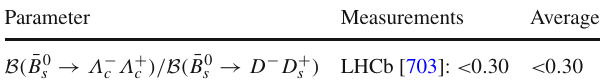
Table 201 Decays to two charm baryons Parameter Measurements